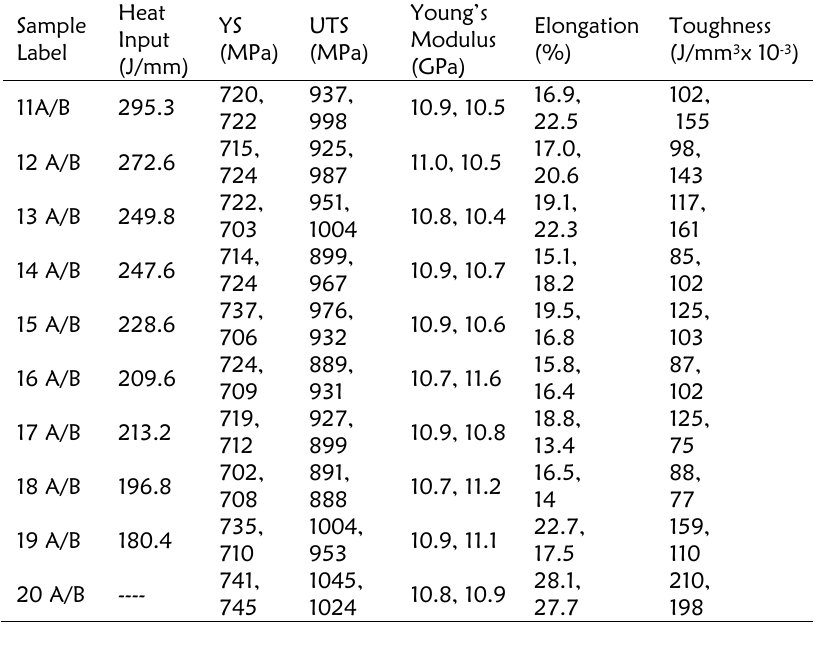
Table 2: Mechanical properties of EBW'ed samples